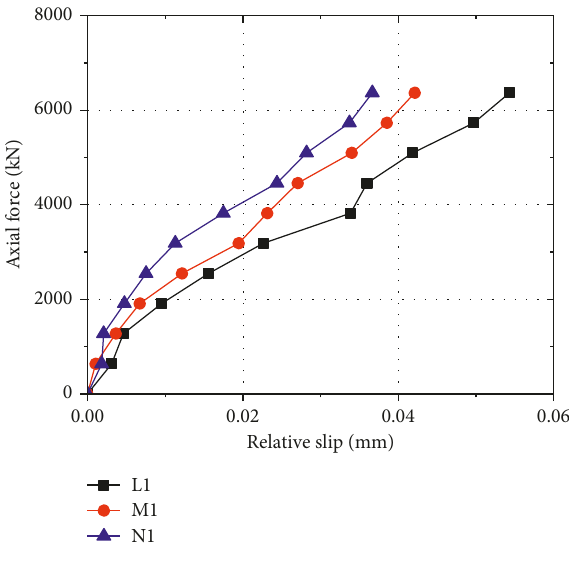
Figure 9: Load-slip curve of the test specimen.